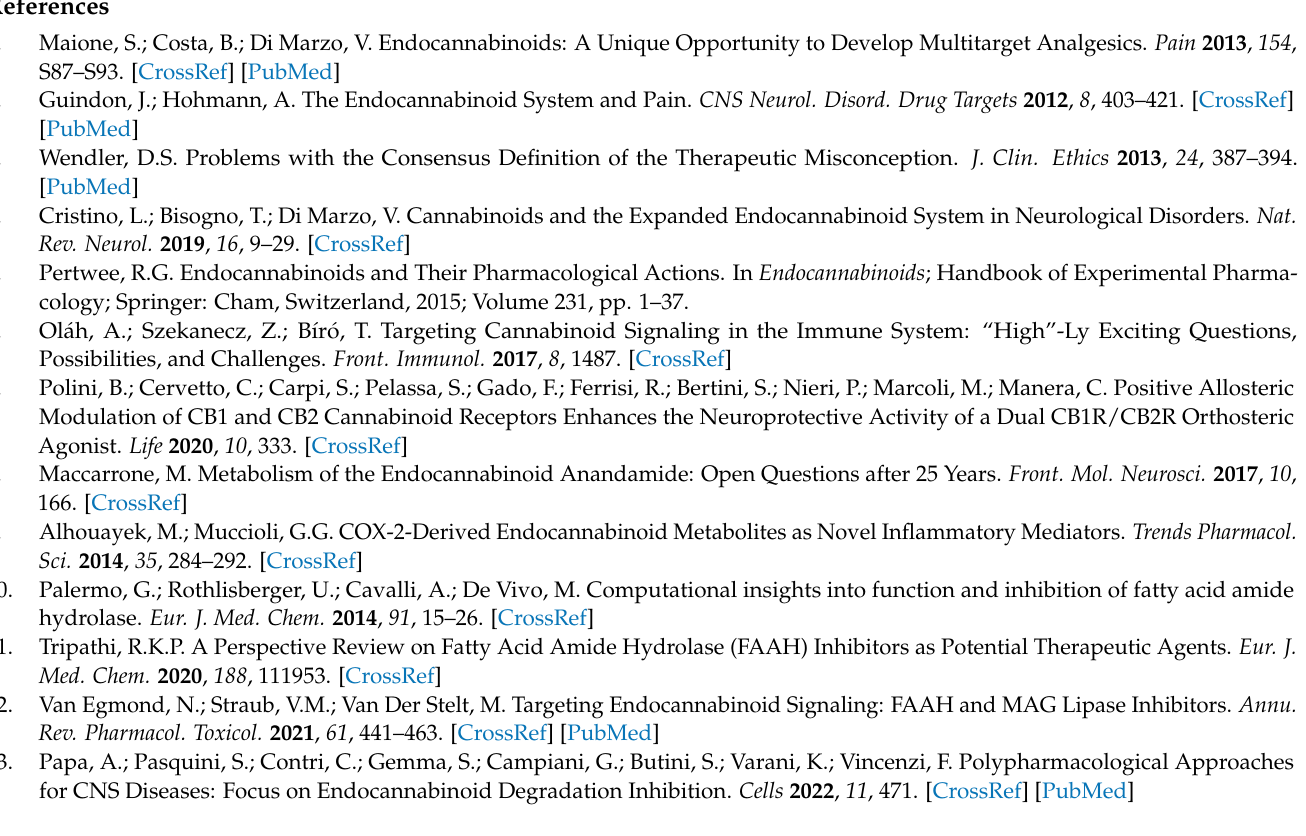
by Fpockets Figure S2: Structural differences between rat and mouse FAAH and position of both docking box1 and box2. Figure S3: Schematic representation of the main “A” and “B” binding mode orientations. Figure S4: TPA14 docking poses in box1 of r FAAH; Figure S5: TPA14 docking poses in box2 of r FAAH; Text S1: Equilibration and properties of the membrane-embedded systems; Figure S6: Membrane properties during system equilibration; Figure S7: Time evolution (100 ns) of the RMSD (Å) of the protein and the ligand TPA14 in monomer A (cyan line) and monomer B (orange line) of r FAAH; Figure S8: Structural differences between the most populated clusters of the B3db1 and the less populated A3db1 binding modes of TPA14 in r FAAH, with ligand/rFAAH key interaction graphs. Figure S9: Root mean square fluctuation (RMSF) (Å) of r FAAH in monomer A and monomer B; Table S2: RMSD of TPA14 in r FAAH; Figure S10: Protein and AEA RMSD (Å) trend in monomer A and monomer B of r FAAH; Figure S11: C α -C β dihedral angles plots of the “dynamic paddle”, forming residues F381, F432 and W531. Figure S12: m FAAH protein RMSD (Å) trend in complex with TPA14; Table S3: Cluster analysis of TPA14 binding mode in m FAAH after 100 ns of MDs; Figure S13: TPA14 RMSD (Å) during 100 ns of MDs in m FAAH; Figure S14: Structural differences between the most populated clusters of TPA14 in the A2db1 solution in m FAAH and the ligand/ m FAAH key interactions; Figure S15: RMSF (Å) of m FAAH in monomer A and monomer B in complex with TPA14. References [44,50–53] are cited in Supplementary